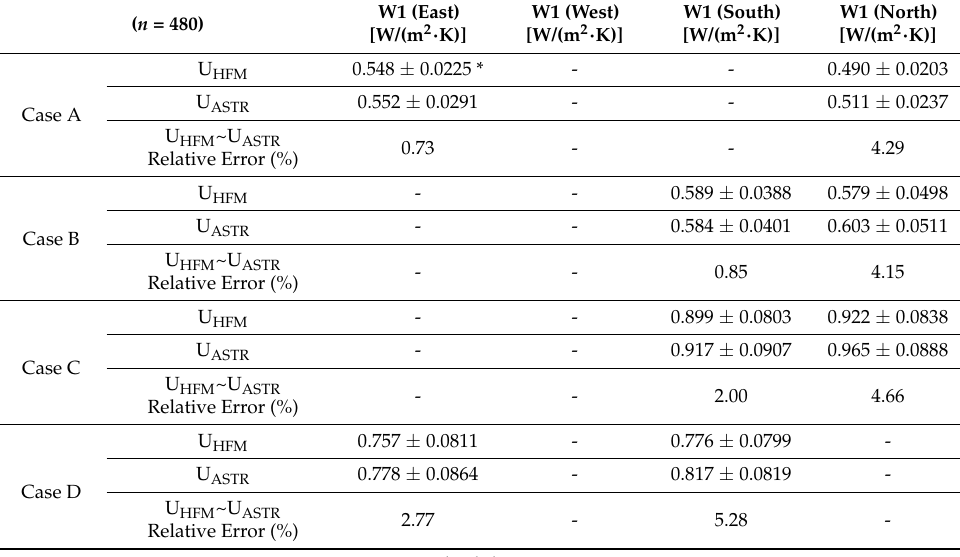
Table 5. Results of wall U-value measurements after